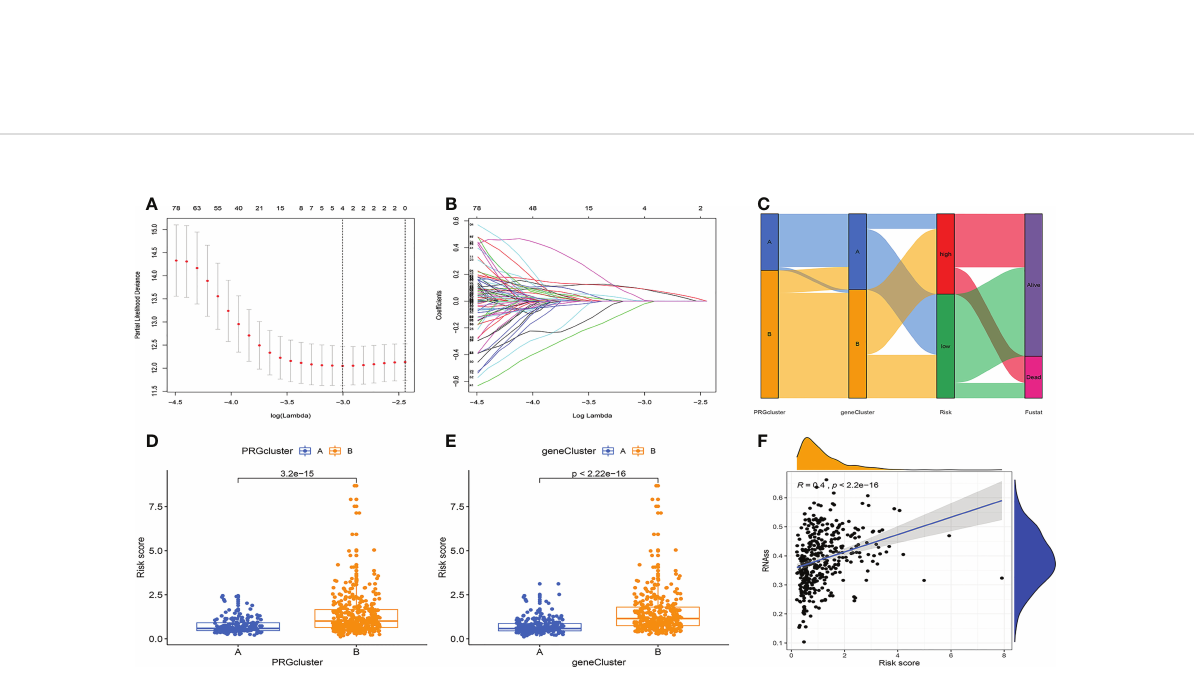
FIGURE 4 Prognostic model construction. (A, B) LASSO regression analysis. 4 genes were screened to build a prognostic model. (C) Distribution of different subtypes, risk groups, and survival outcomes. (D, E) Distribution of risk scores for different subtypes. (F) RNAss values are positively correlated with risk scores.